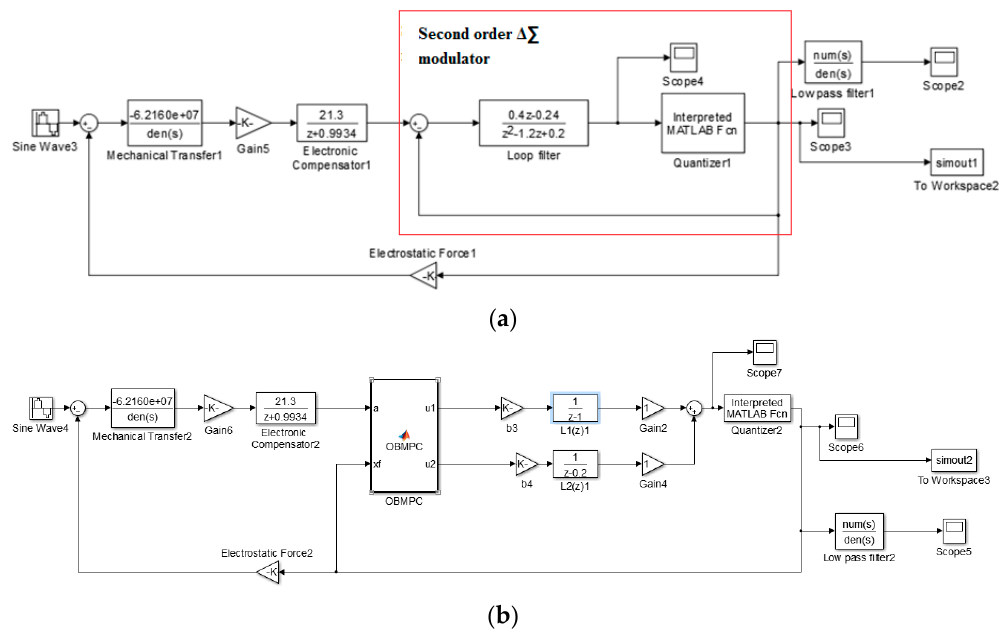
Figure 10. ( a ) Simulation structure of the ∆∑ modulator based MEMS gyroscope; ( b ) Simulation structure of the OBMPC-based MEMS gyroscope.